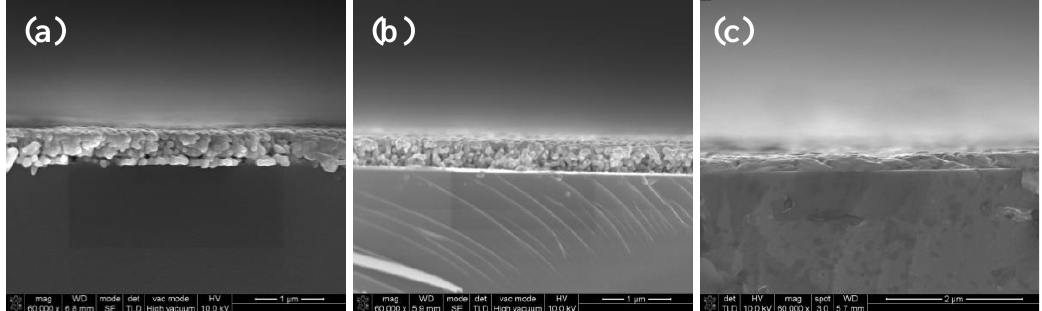
Figure 9. SEM images of cross section of heat-cured silver films based on MOD ink at: ( a ) 160 °C; ( b ) 180 °C; ( c ) 200 °C for 10 min.